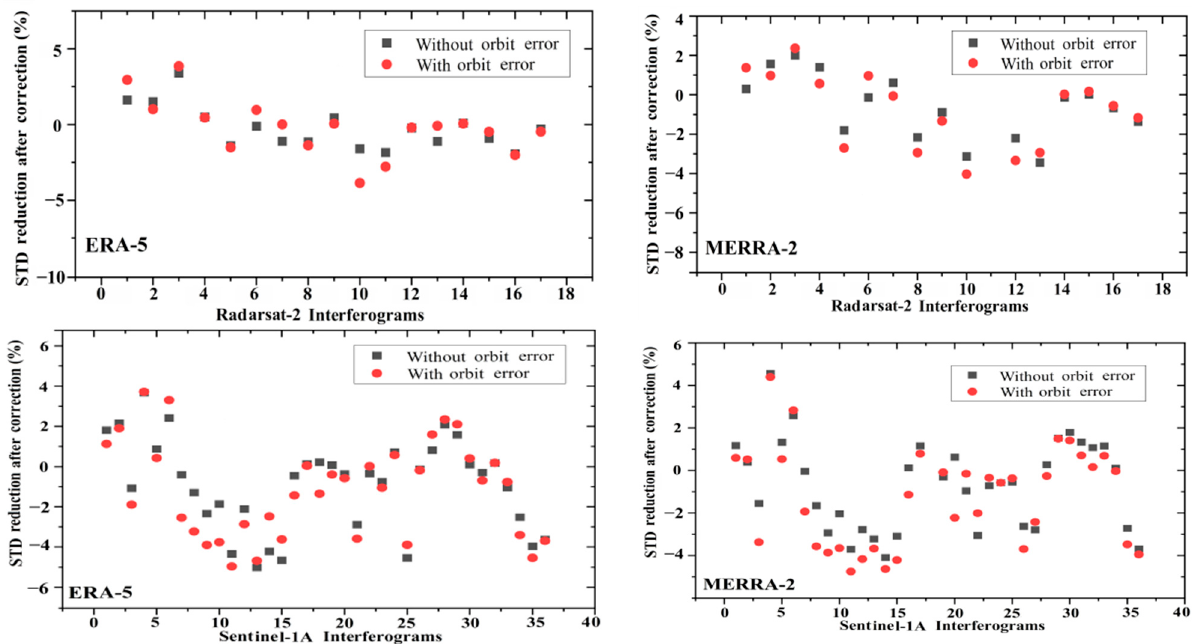
Figure 5. Evaluation of the effect of orbital errors on the hydrostatic delay (Radarsat-2 interferograms in the first row and Sentinel-1A interferograms in the second row).